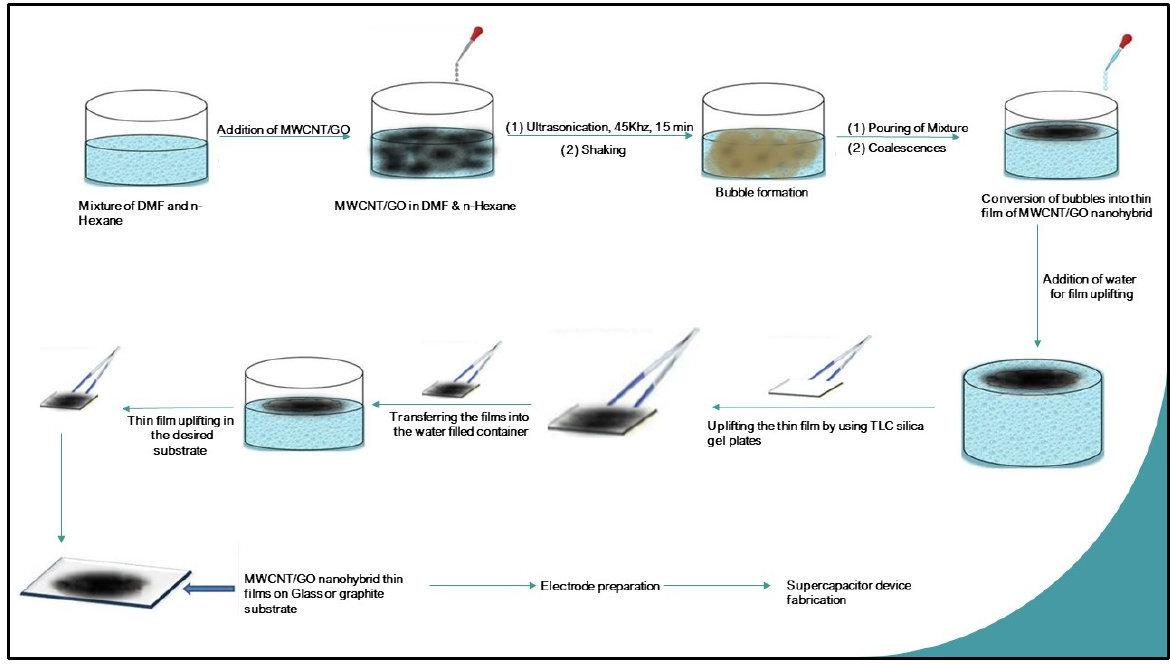
Figure 10. Schematic scheme for the preparation of MWCNT/GO nanohybrid thin films on a glass substrate via the solvent - antisolvent technique.